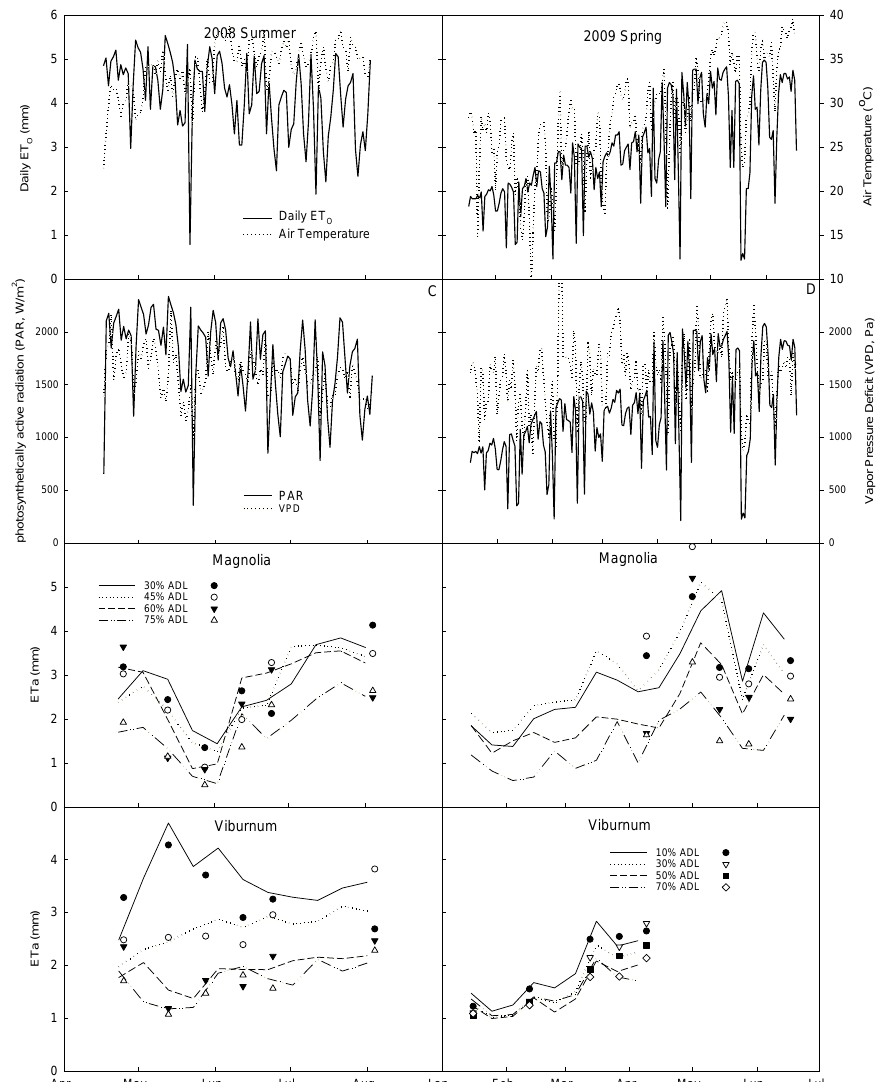
Figure 2. ( A – D ) Atmospheric conditions during two experimental periods, summer of 2008 and spring of 2009, as well as ( E – H ) woody plant water use for southern magnolia ( Magnolia grandiflora; n = 4) and sweet viburnum ( Viburnum odoratissimum; n = 3) growing in lysimeter containers and subjected to four levels of allowable soil water depletion levels (ADLs). ( A – B ), Daily reference evapotranspiration (ET O ) and air temperature; ( C – D ), incoming photosynthetically active radiation and vapor pressure deficit; ( E – H) , normalized ET A (measured volumetric water use ÷ PCA) with a 10-day rolling ET A (lines) and actual ET A (data marks) on the day of PCA measurement for both periods. Dates showing mean separation letters (a, b, c) are significantly different at p < 0.05. Letters with an asterisk indicate adjacent data points that are not significantly different.